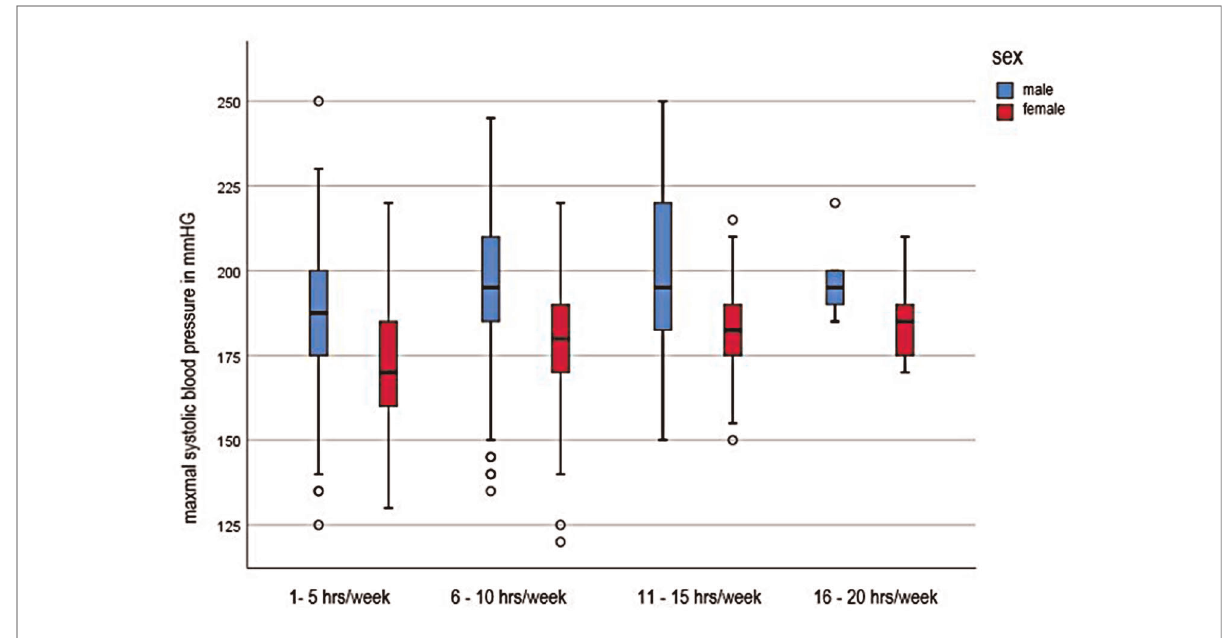
FIGURE 2 Systolic maximal blood pressure in dependence of training intensity.